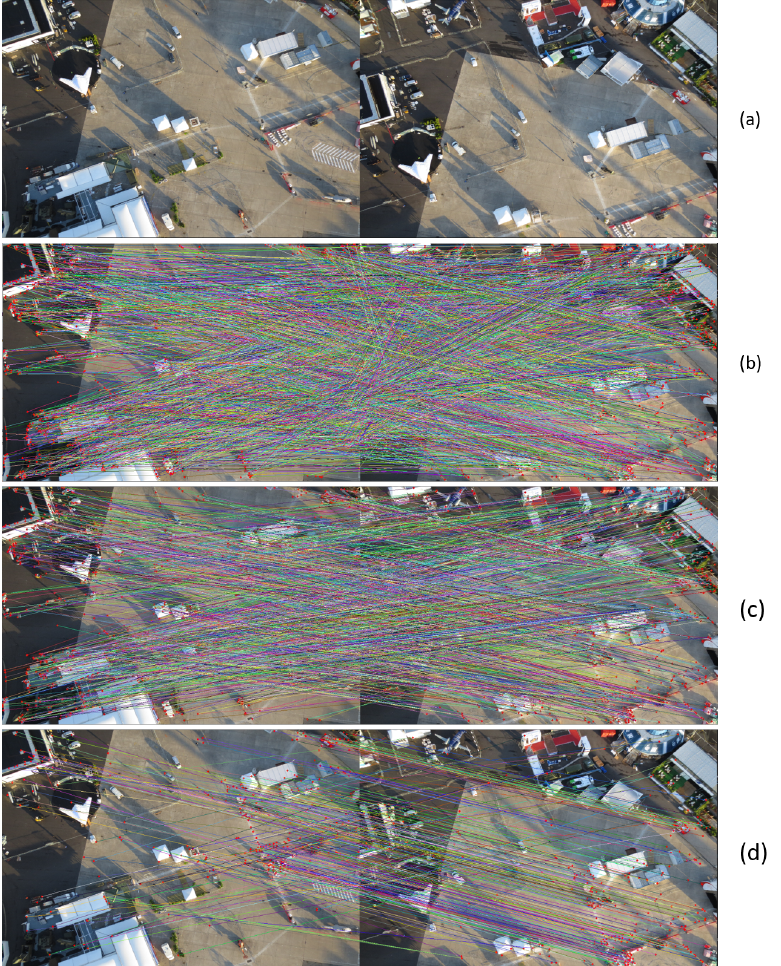
Figure 3. The construction of one reduced correspondence set by using the proposed GH-based mismatch removal strategy. ( a ) The input image-pair. ( b ) The initial correspondence set C ini shown by those 2643 lines. ( c ) The reduced correspondence set C θ , k 1 shown by those 1390 lines. ( d ) The reduced correspondence set C reduced , GH shown by those 392